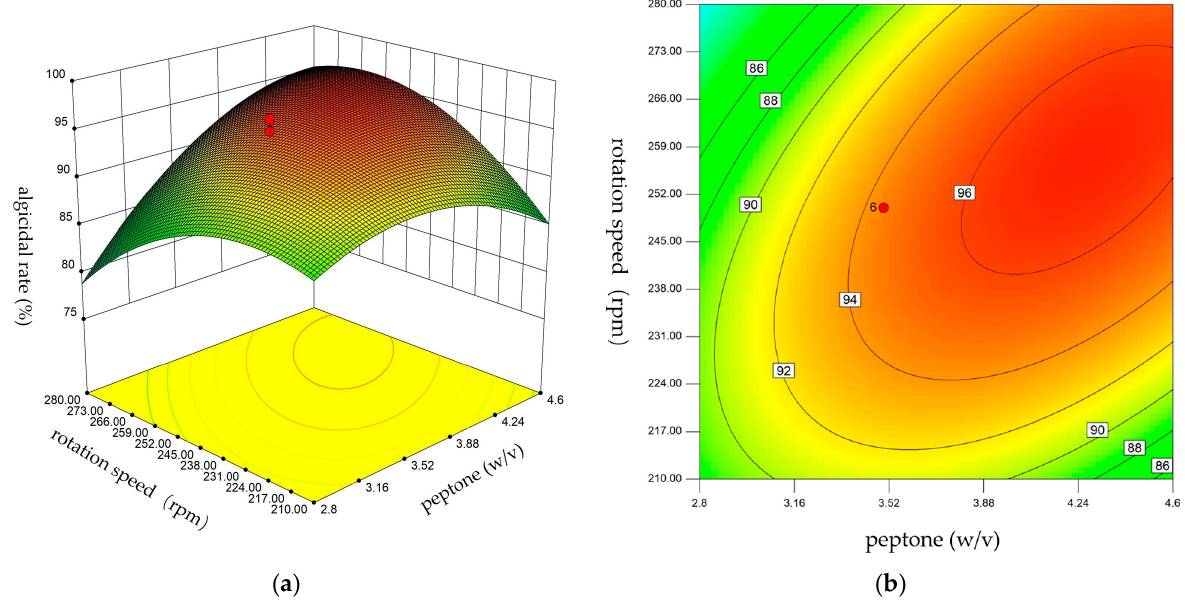
Figure 4. Three-dimensional response surface curve plots ( a ) and the contour plot ( b ) for algicidal rate of rotation speed and bacterial peptone.